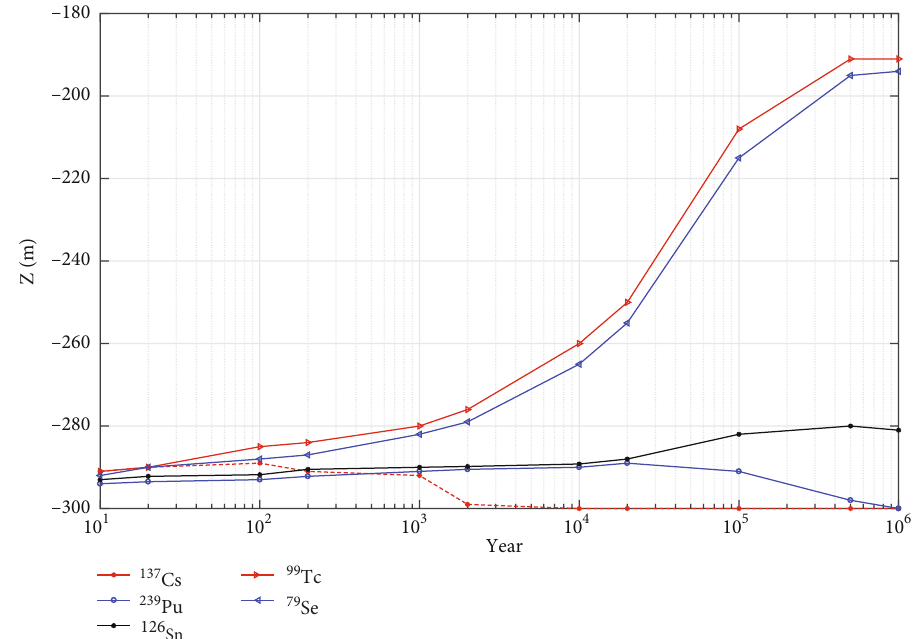
Figure 16: Depths at which the annual dose of each radionuclide has decreased to 0.01 mSv/y (dose above each line < 0.01 mS/y). D = 5 × 10 − 10 m 2 /s , 0.5km disposal borehole and k = 10 − 16 m 2